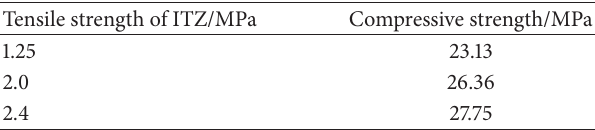
Table 5: Compressive strengths of RAC with different tensile strengths of